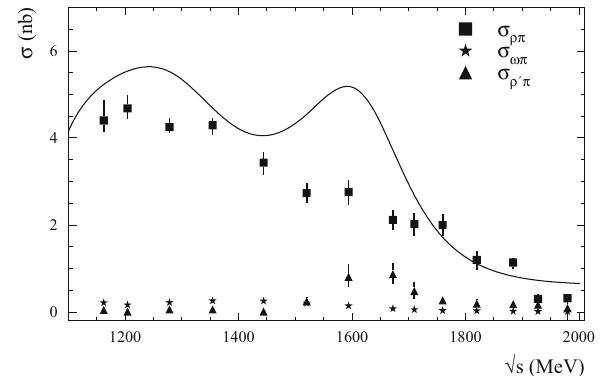
Fig. 7 The measured energy dependences of the cross sections σ ρπ , σ ρ (cid:6) π , and σ ωπ . The curve is the result of the fit to the SND data on the total e + e − → π + π − π 0 cross section (see Fig. 4)